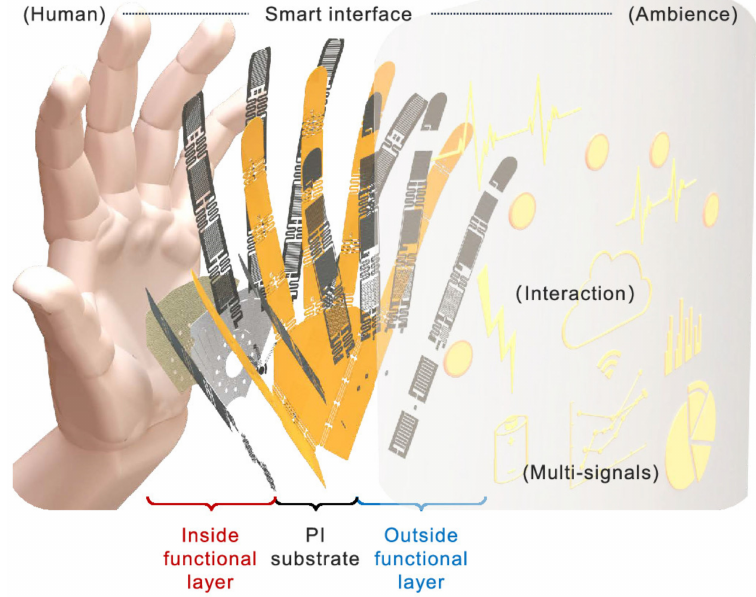
Figure 7. The multifunctional sensing system with an anti-interference design. Reproduced with permission from [20]. Copyright 2022 American Chemical